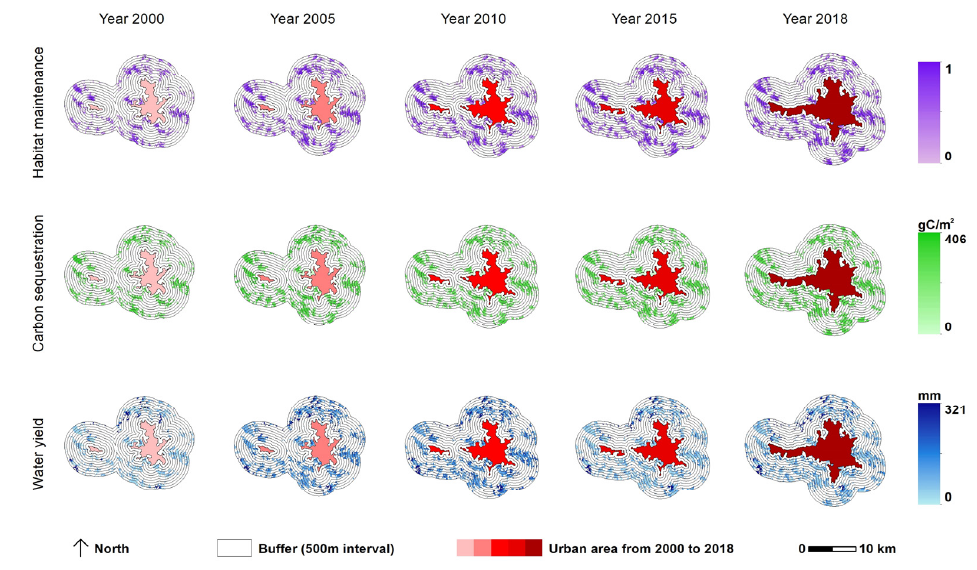
Figure 5. The spatiotemporal change of considered landscape functions in the urban periphery of Liaoyuan city from 2000 to 2015.